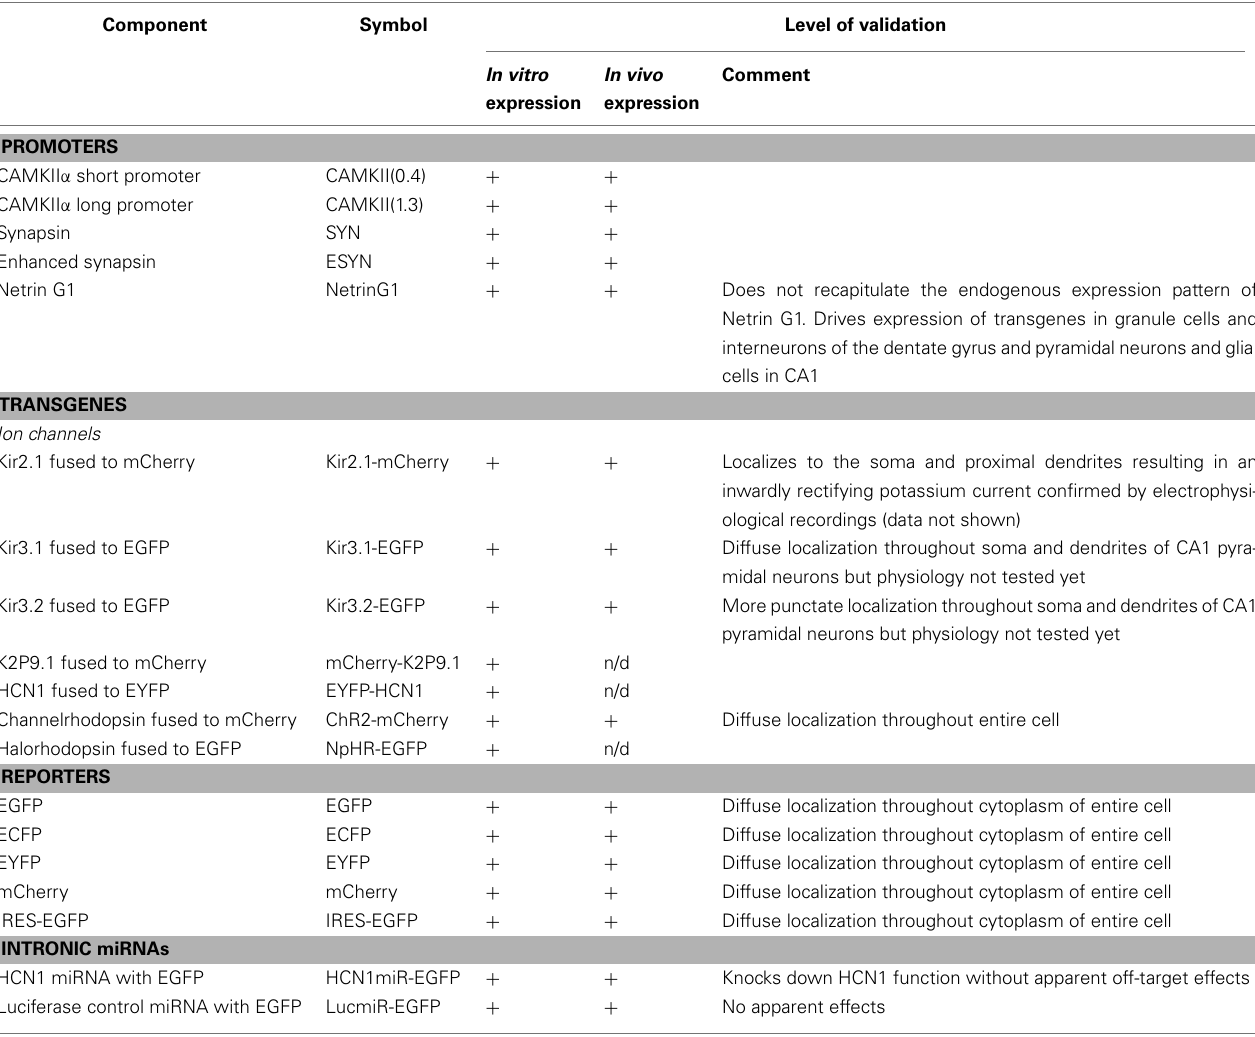
Table 1 | Molecular toolbox